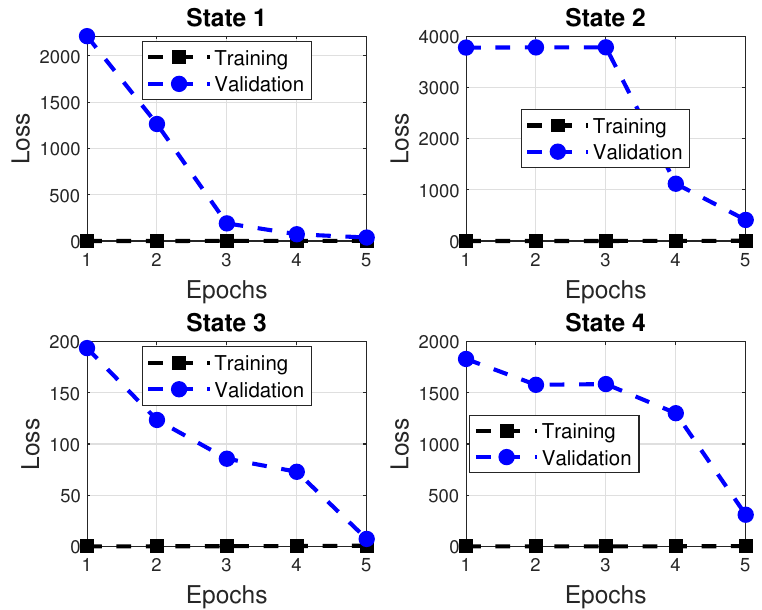
Figure 3. Training and validation MSE losses for